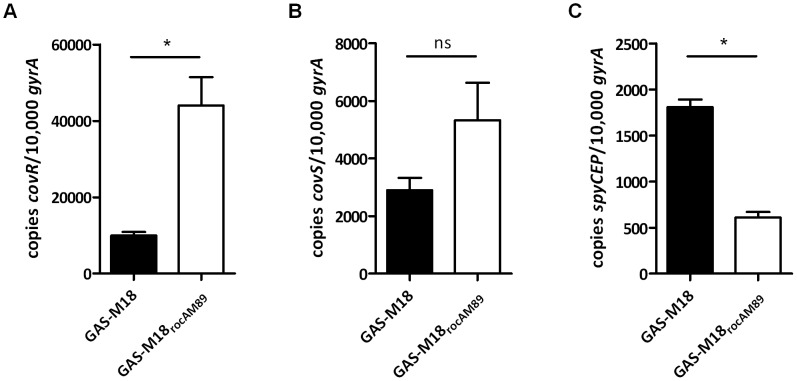
Functional RocA enhances covR but not covS transcript levels.RT-PCR analysis of isogenic strains GAS-M18 and GAS-M18rocAM89 to ascertain the impact of RocA on expression of global regulator CovR. Quantification of absolute copy number of (A) covR, (B) covS and (C) spyCEP transcripts relative to housekeeping gene gyrA at EL growth phase. Data represent mean and standard deviation for three independent experiments measured in triplicate (un-paired t-test, * = p<0.05).